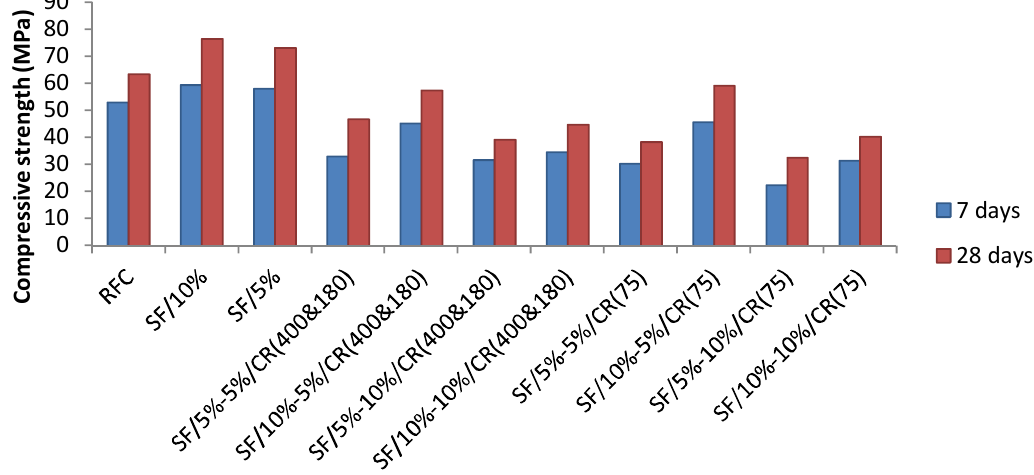
Figure 8. Compressive strength of crumb rubber concrete.